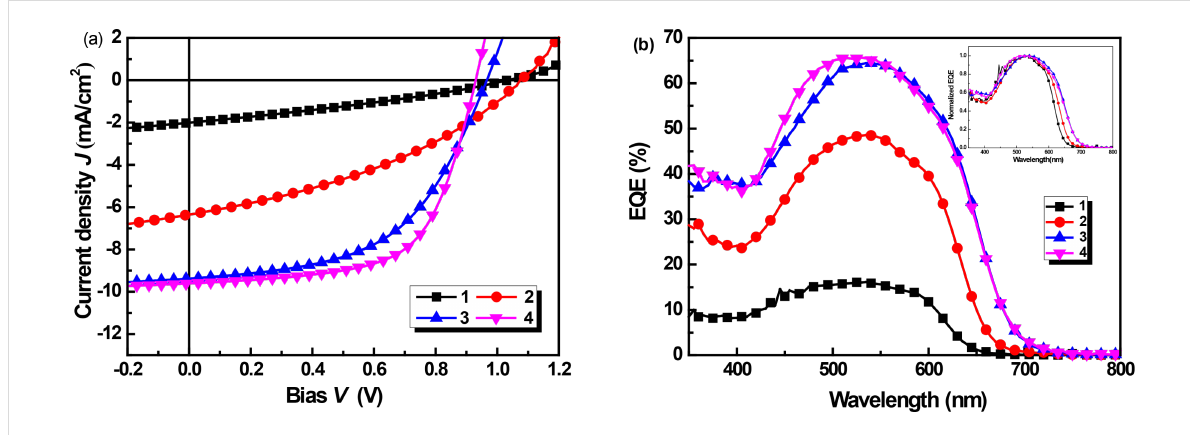
Figure 3: (a) J – V curves of the best COOP- n HT-TBDT:PC 61 BM solar cells; (b) EQE spectra of the corresponding cells, Inset: normalized EQE spec- tra of four best devices, showing the difference in spectrum response wavelength range.